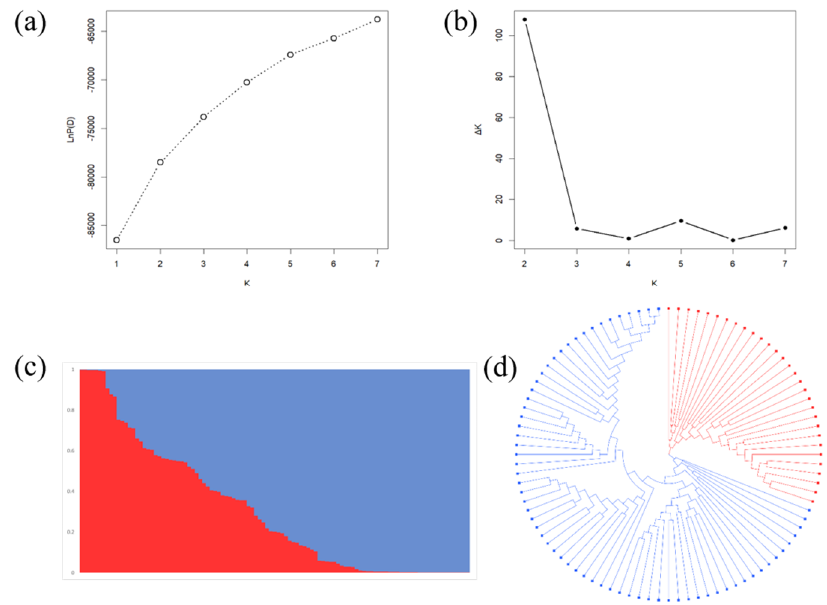
Figure 3. The population structure of 105 wild soybean accessions. ( a , b ) LnP (D) and Δk based on 20 runs of STRUCTURE analysis. ( c ) The population structure at K = 2 estimated by STRUCTURE. There are two colored segments, with each representing the percentage belonging to each subpopulation. ( d ) A neighbor-joining tree of the 105 accessions divided into two subpopulations.